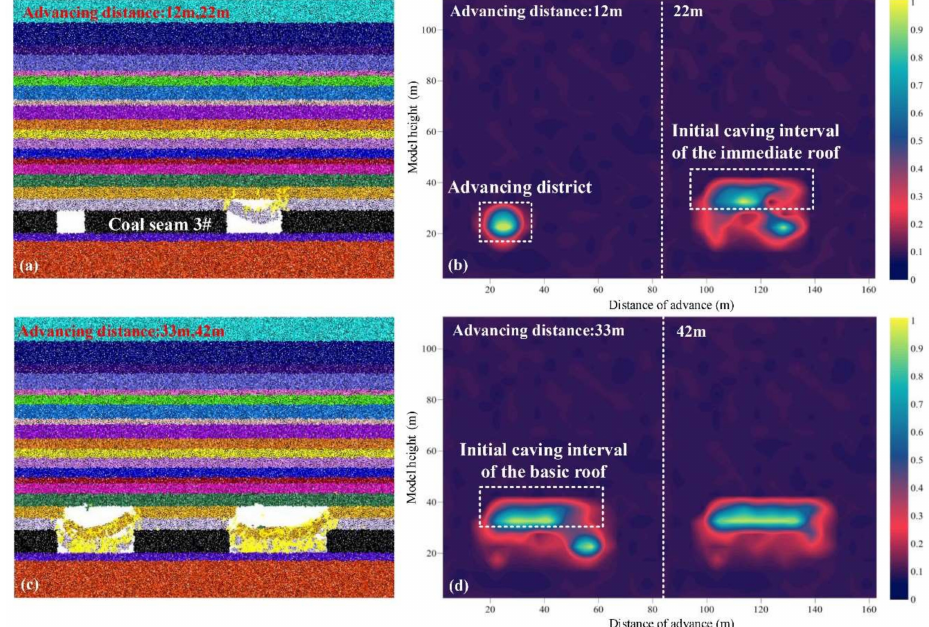
Figure 8. Dynamic evolution of cracks and porosity simulated with PFC 2D , showing changes in cracks in overburden strata during heading to 12 m, 22 m ( a ), 33 m, and 42 m ( c ) prior to the face; and changes in porosity at 12 m, 22 m ( b ) and 33 m, and 42 m ( d ). The changes in porosity level are denoted by the change in color scale through the corresponding numerical